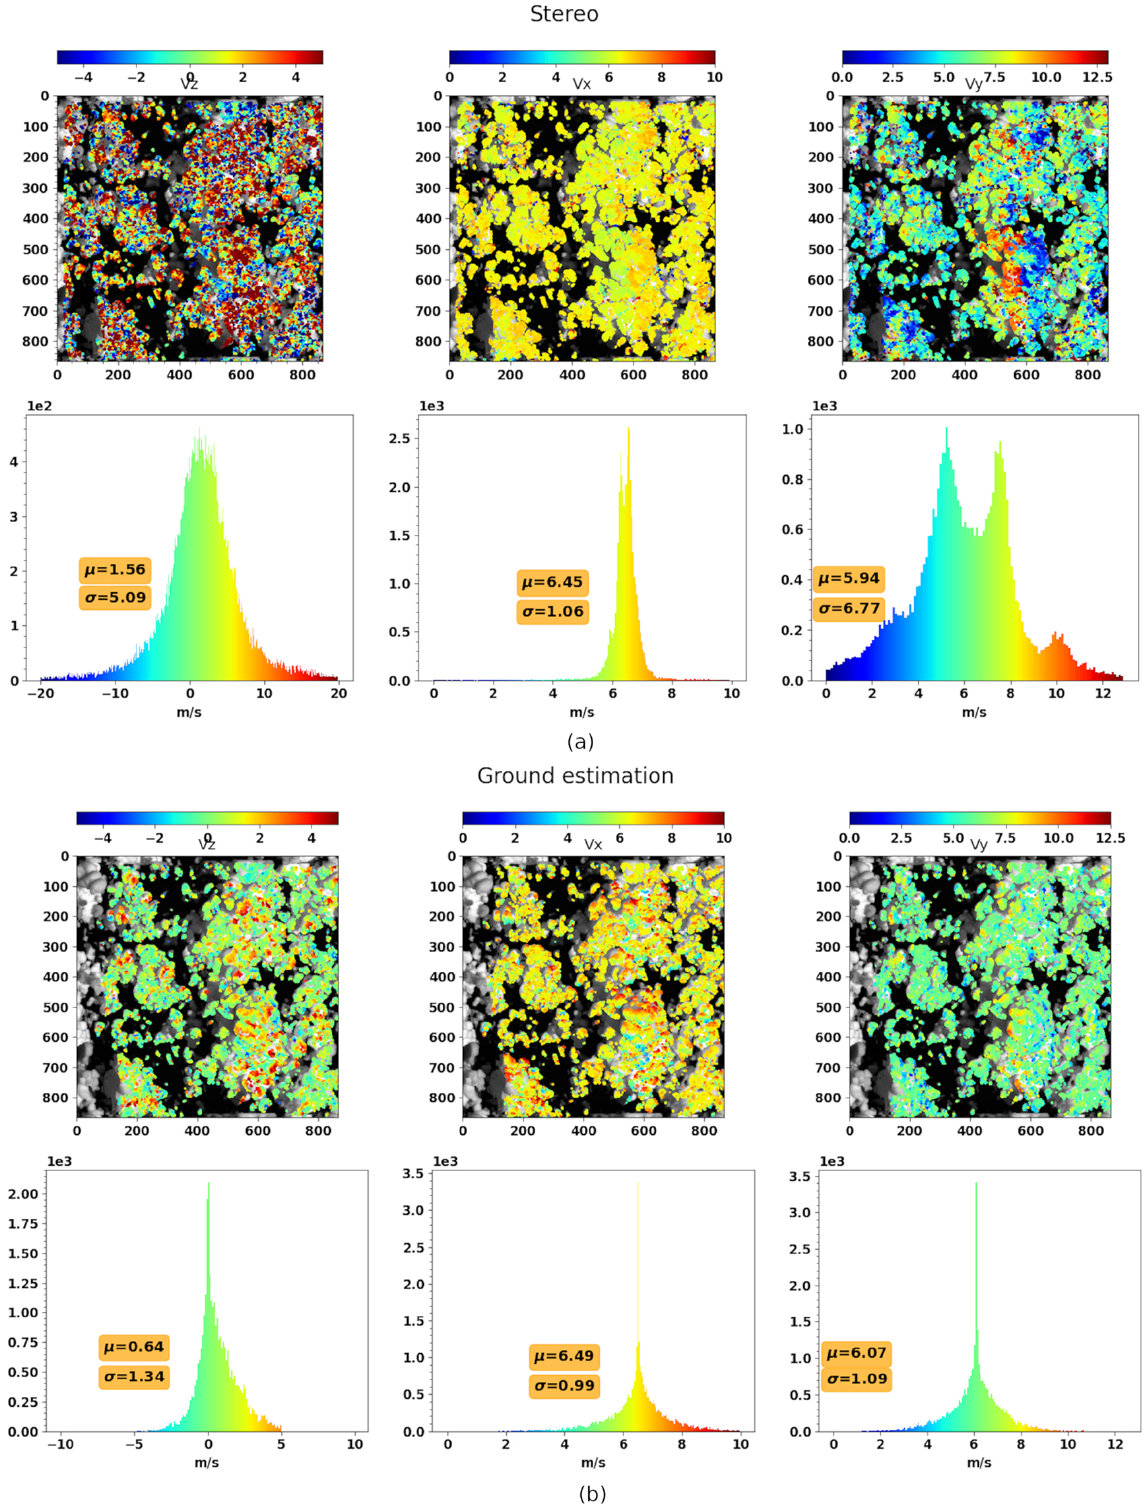
Figure 12. (a) STV (stereo velocity) from A5–A6. Top part from left to right: the components z , x , and y of the retrieved velocity STV. Bottom part from left to right: z , x , y distributions. (b) Same as in panel (a) but for GEV (ground estimation